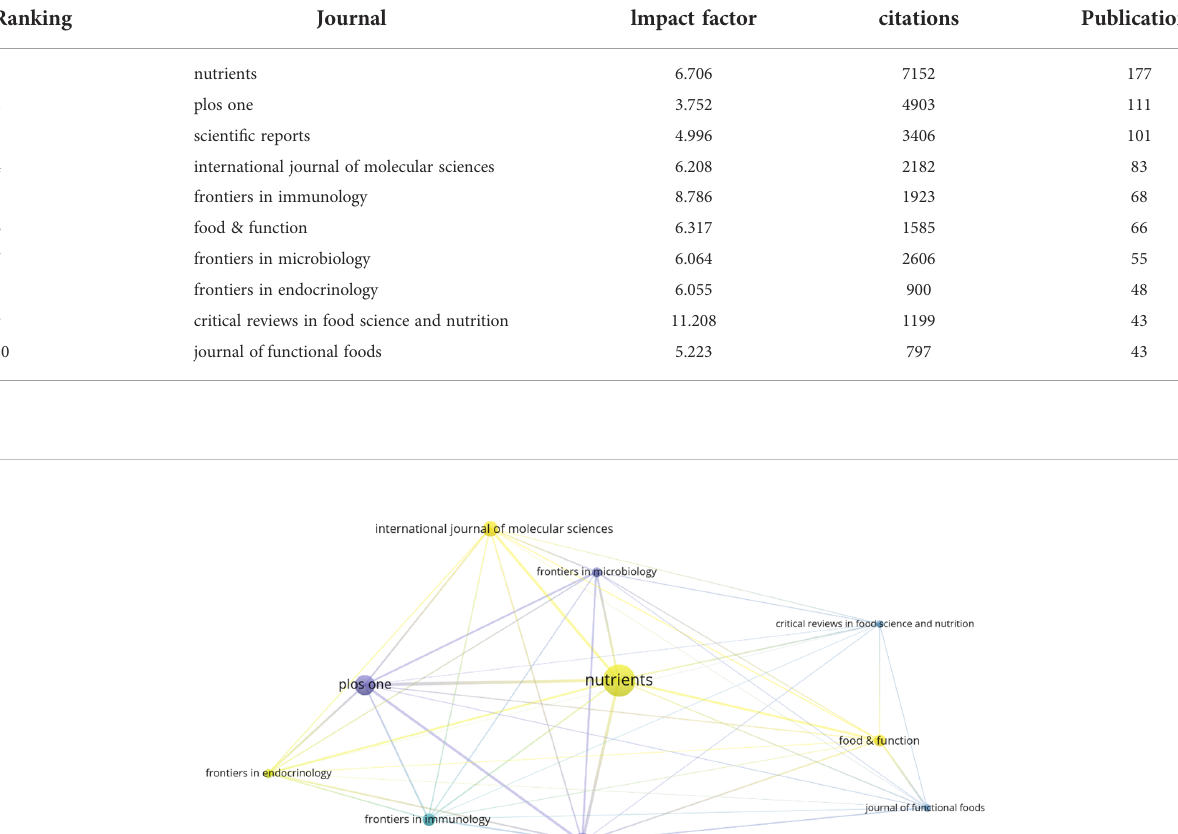
TABLE 5 Top 10 journals with the highest number of articles.